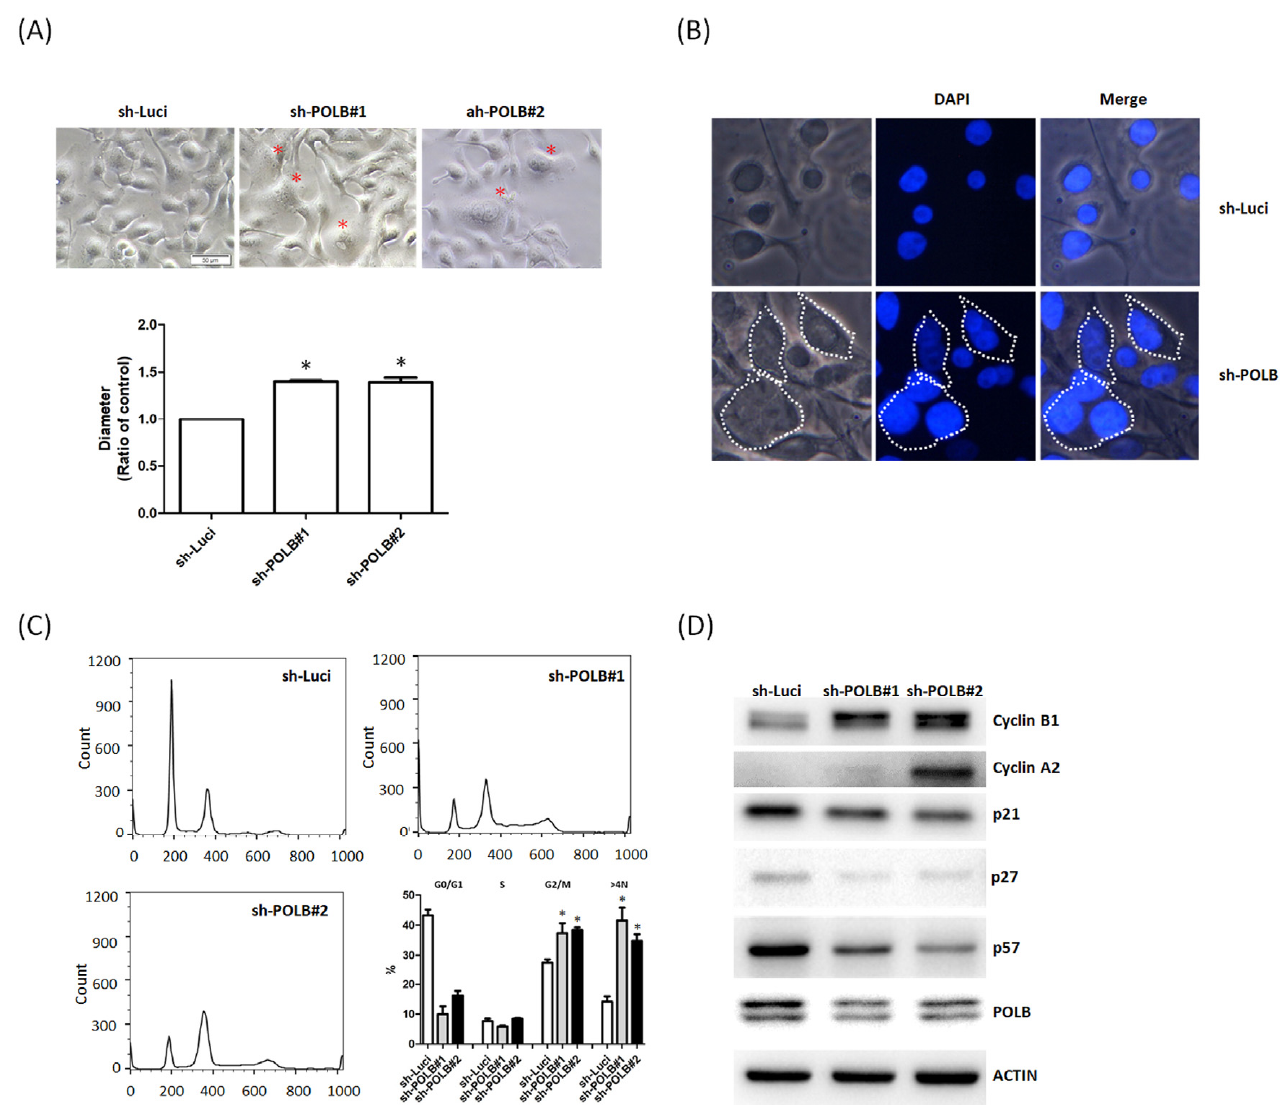
Figure 3. Depletion of POLB induces aneuploid cells in Ca9-22 cells. ( A ) Morphology of Ca9-22 and POLB-depleted Ca9-22 cells were visualized under a light microscope. Candidate binucleated and multinucleated cells are indicated with red stars. Quantitative analyses of nuclear size are shown in the right panel. ( B ) Cell nuclei of Ca9-22 and POLB-depleted Ca9-22 cells were stained with DAPI solution (blue color). The fluorescent image was observed under a fluorescence microscope. ( C ) Next, cells were stained with propidium iodide (PI) followed by flow cytometry analysis to obtain cell cycle distribution of Ca9-22 and POLB-depleted Ca9-22 cells. Data are representative of three independent experiments. N, haploid number. ( D ) Levels of indicated proteins were analyzed by Western blotting in Ca9-22 and POLB-depleted Ca9-22 cells. Anti-actin was used as a loading control. Statistically significant data are indicated by * for significance at p <